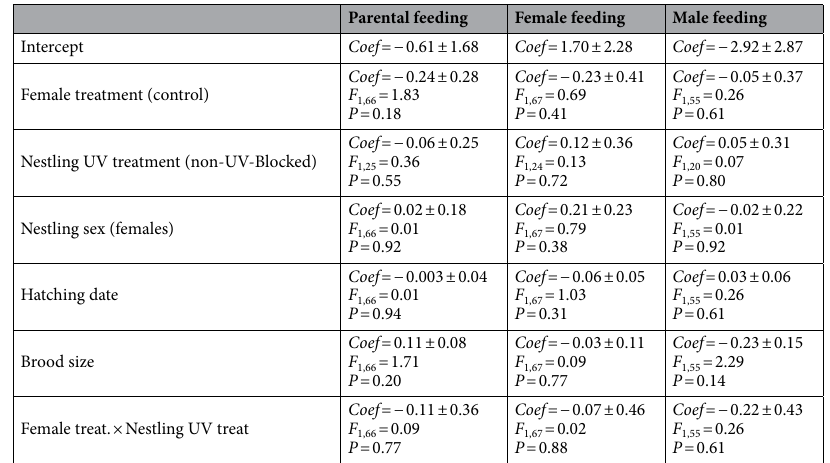
Table 1. Mixed models showing the effects of nestling UV treatment (non-UV-blocked/UV-blocked feather colouration) and female treatment at laying (control/lutein-supplemented) on the number of preys provided by both parents, and by males and by females separately. Coefficients are shown for control nests, non-UV- blocked nestlings and